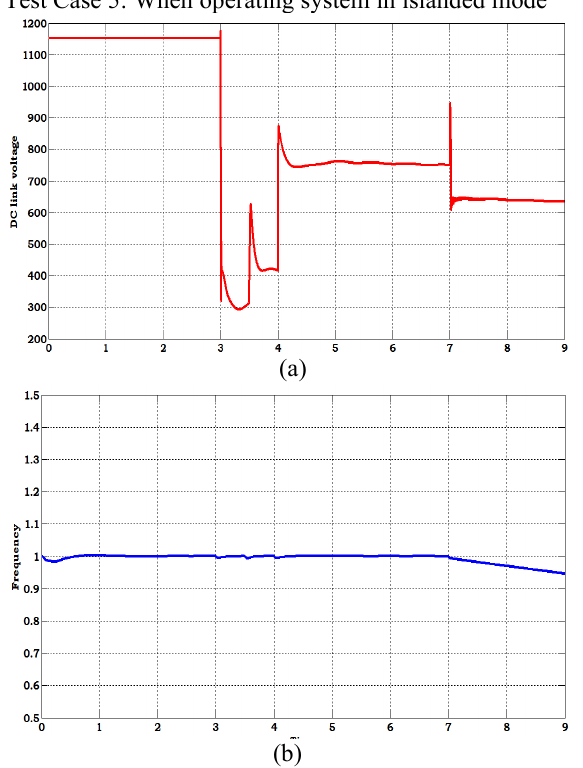
Figure 27. (a). DC link voltage, (b).Frequency